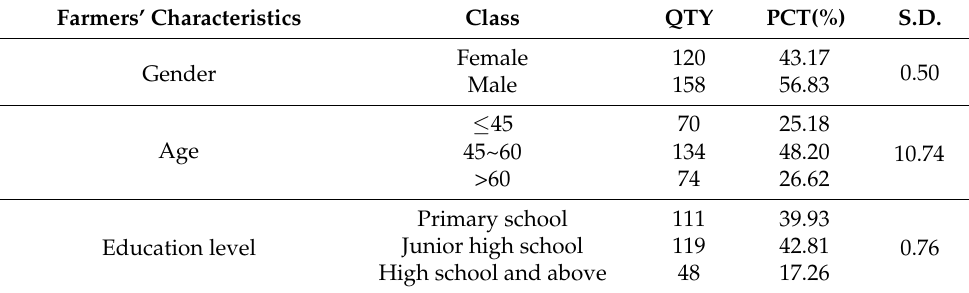
Table 2. Descriptive statistics of respondents’ basic